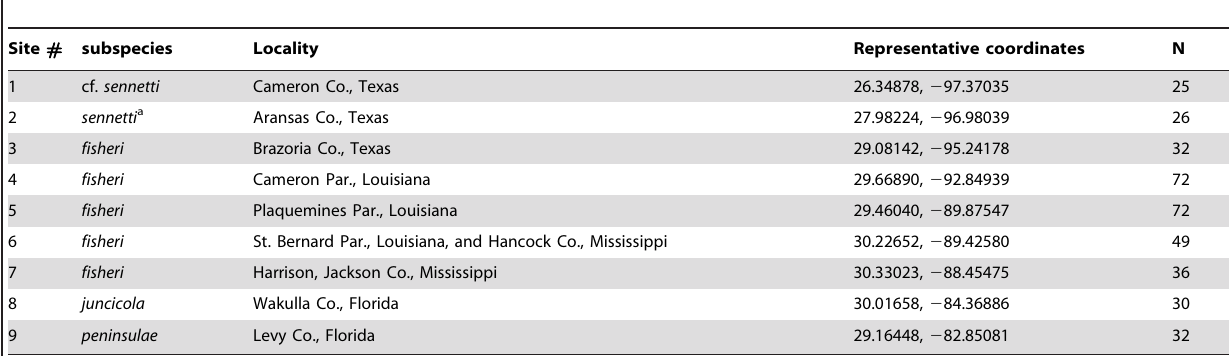
Table 1. Sampling localities, presumed subspecies and sample sizes of Seaside Sparrow used in the Gulf-wide analyses of population genetic